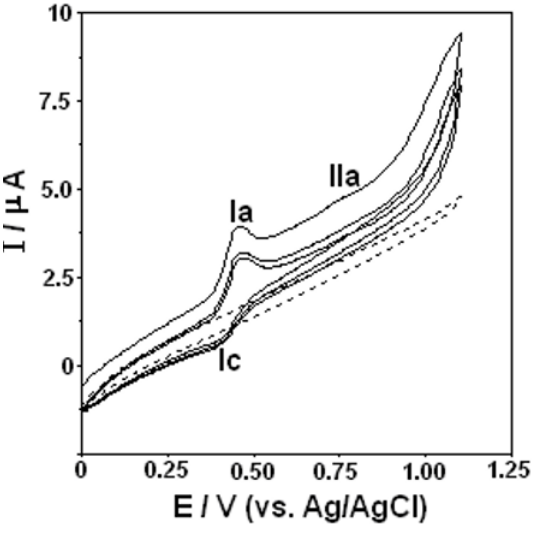
Figure 1. The cyclic voltammograms of 400 µg mL -1 rutin solutions in BR buffer pH 4.0. Scan rate, 100 mV s -1 . Dashed lines represent background